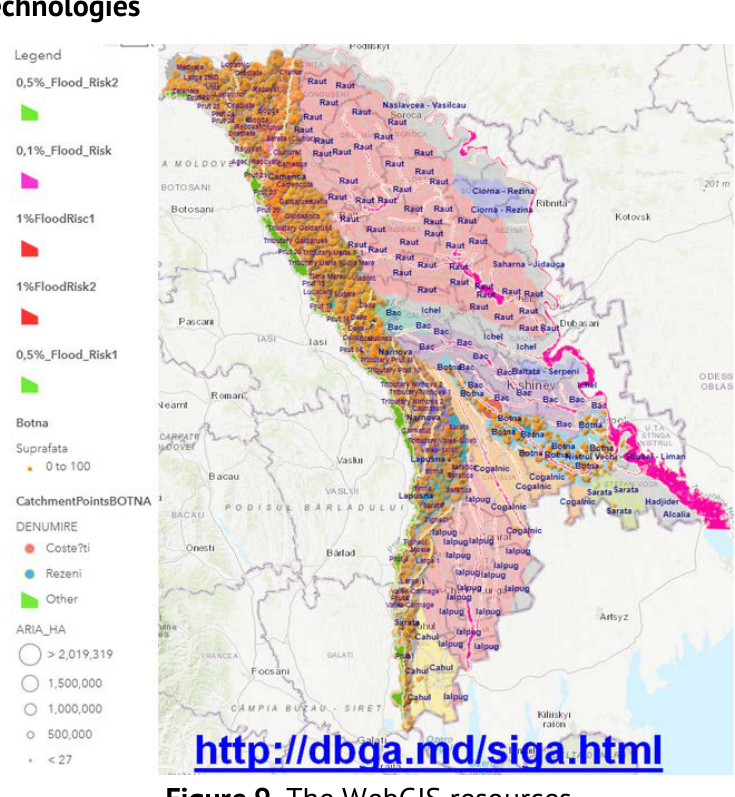
Figure 9. The WebGIS